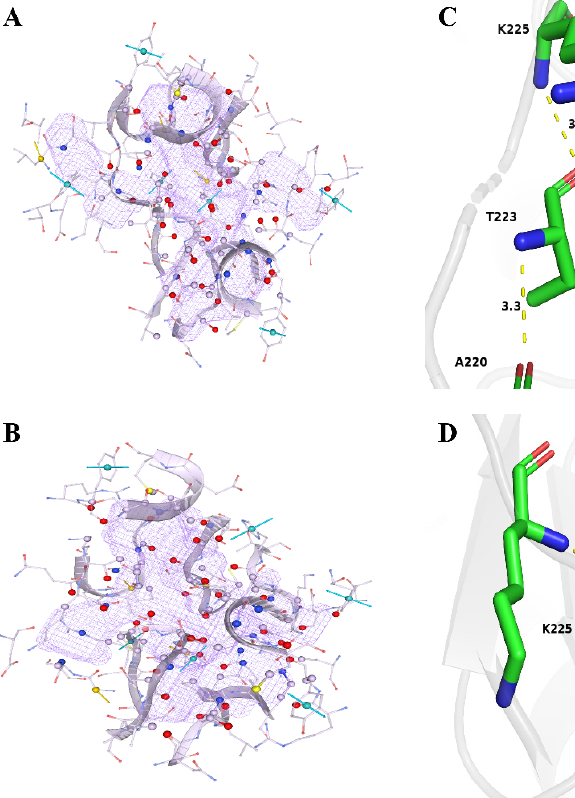
Figure 6. The binding patterns of wild-type and mutant ILRAC complexes with L-asparagine after 100 ns MD. The orange cartoon represents wild-type and the blue cartoon represents mutant ILRAC. ( A ) The overlay of wild-type and ILRAC. The sphere indicates the substrate L-asparagine. ( B ) Al- terations in the substrate binding site. ( C ) The interaction of wild-type with L-asparagine. ( D ) The interaction of mutant ILRAC with L-asparagine. The yellow dashed line represents the hydrogen bond.